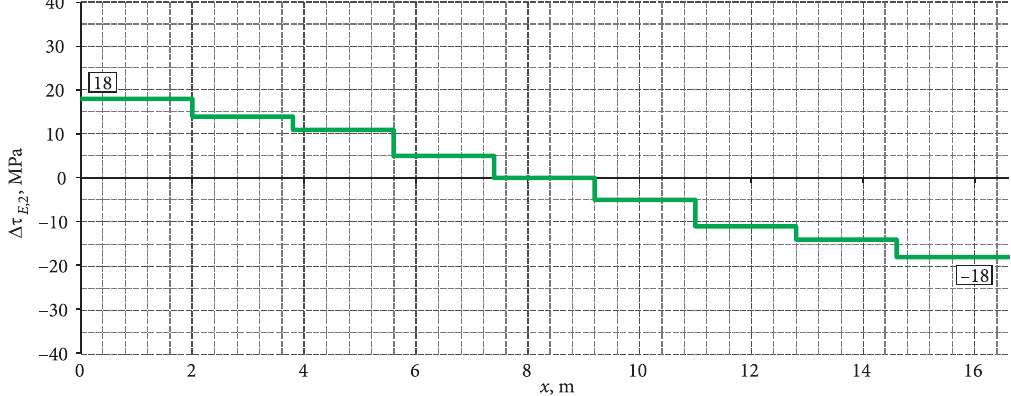
Fig. 13. Distribution of the shear stress range spectrum ∆τ E ,2 for the main railway bridge